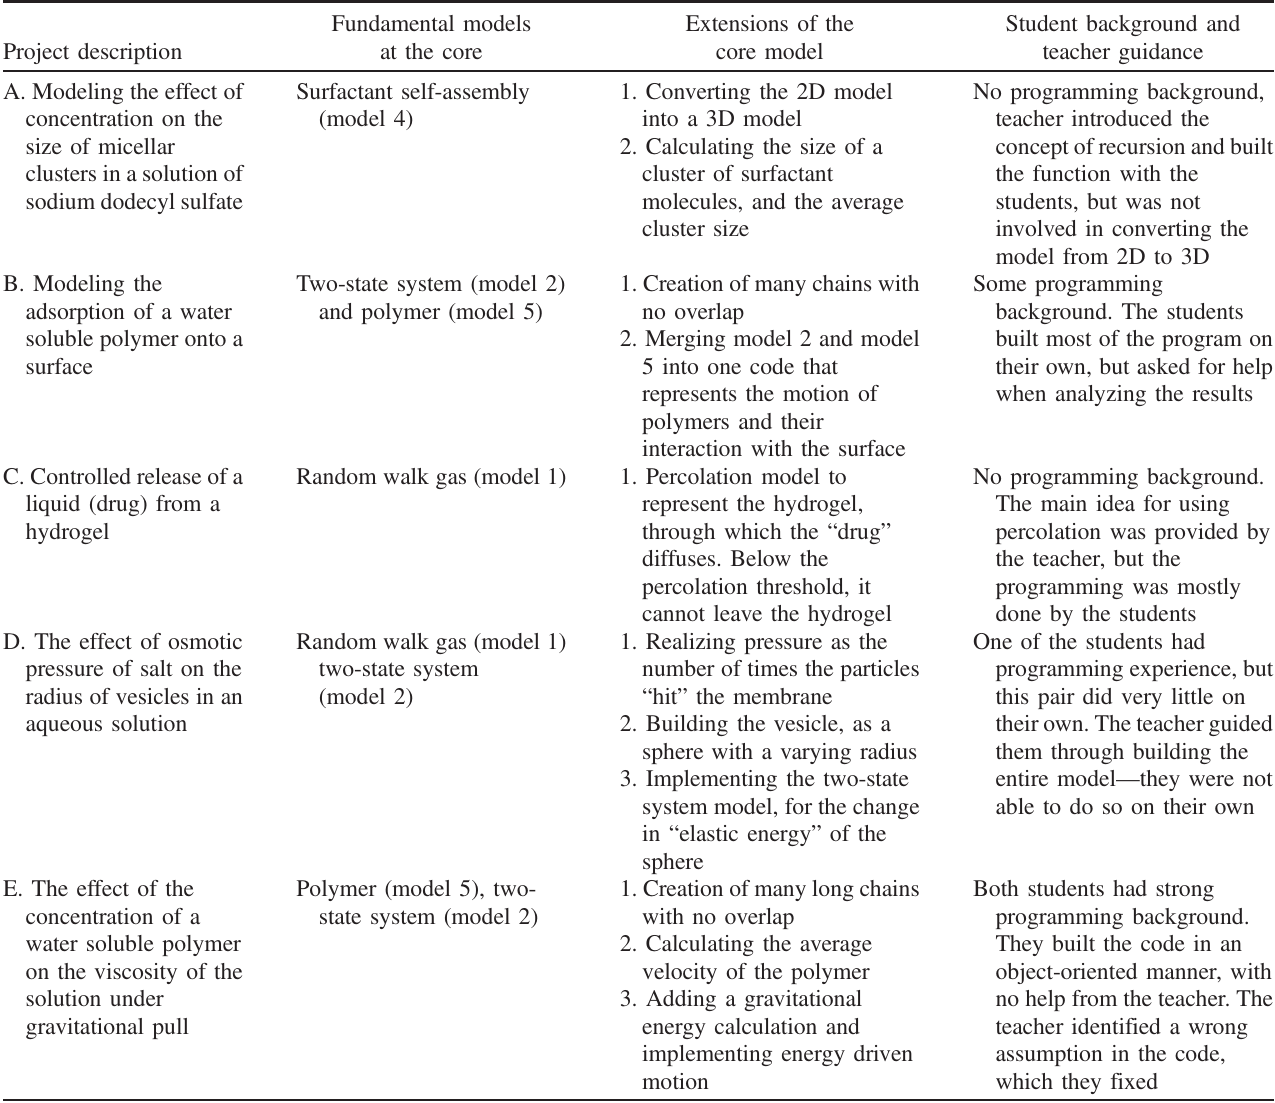
TABLE II. Sample student projects from the redesigned course with descriptions of the core models, their extensions, and teacher